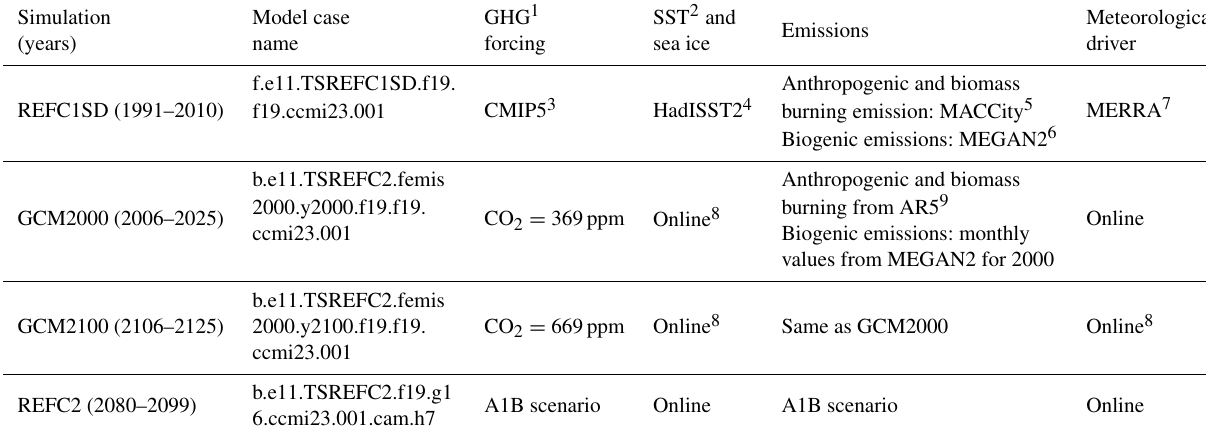
Table 1. The model case names used in this study. Designated model descriptions for the four attribution cases. Online means that the model calculates the meteorology prognostically online. Case names are based on names described previously (Eyring et al., 2013; Sun et al.,